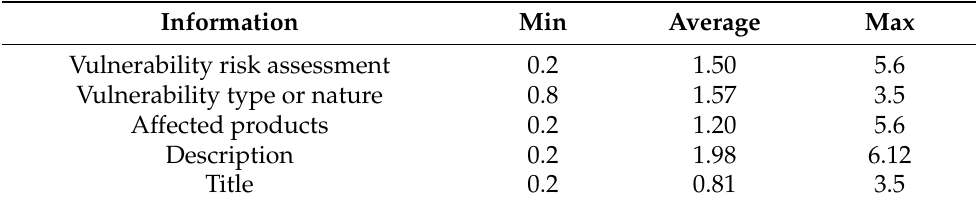
Table 7. Statistics of the highest trust value within the most important